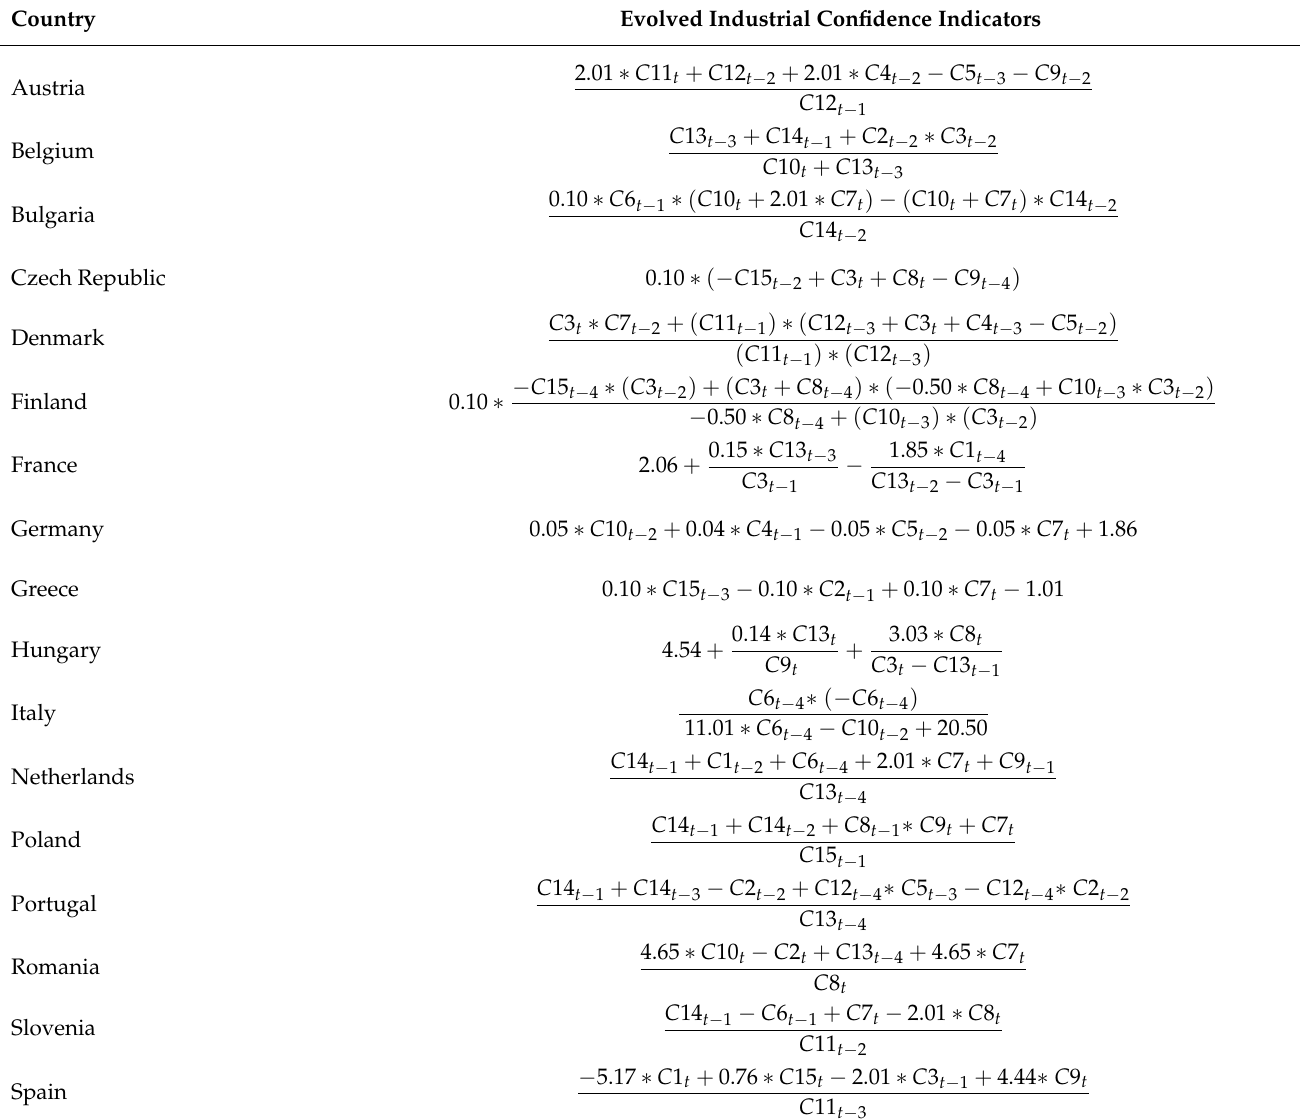
Table 2. Evolved consumer confidence